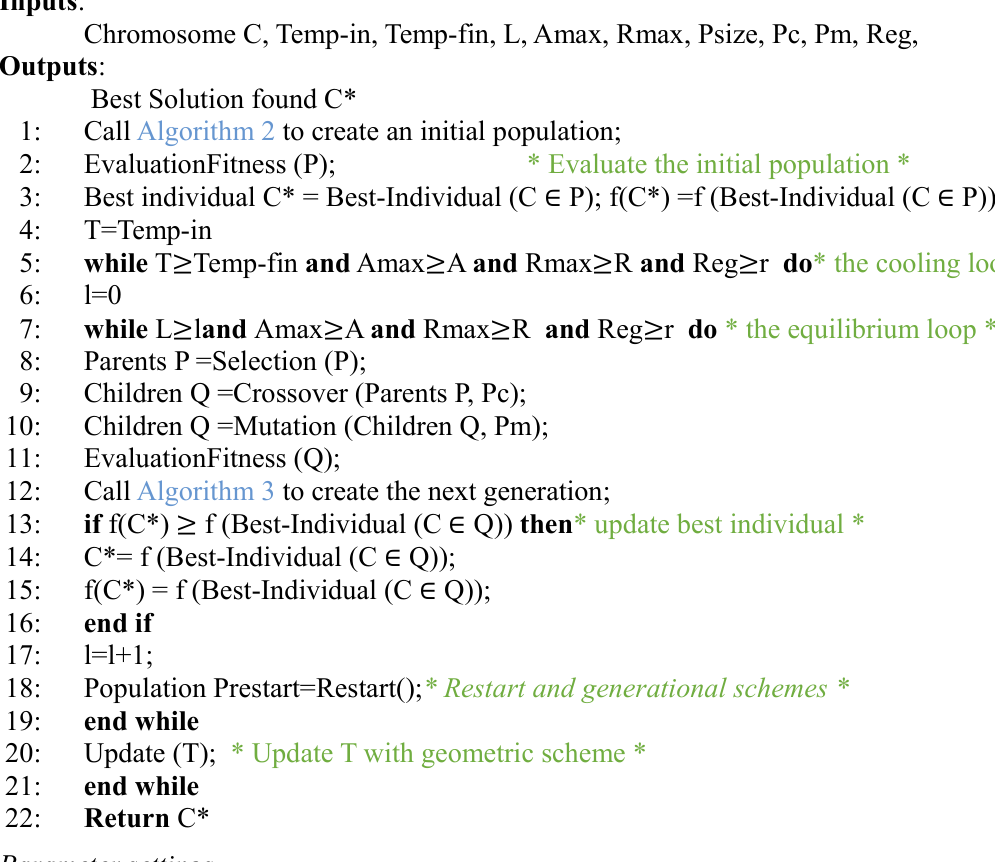
Algorithm 6 . The primary step of the proposed